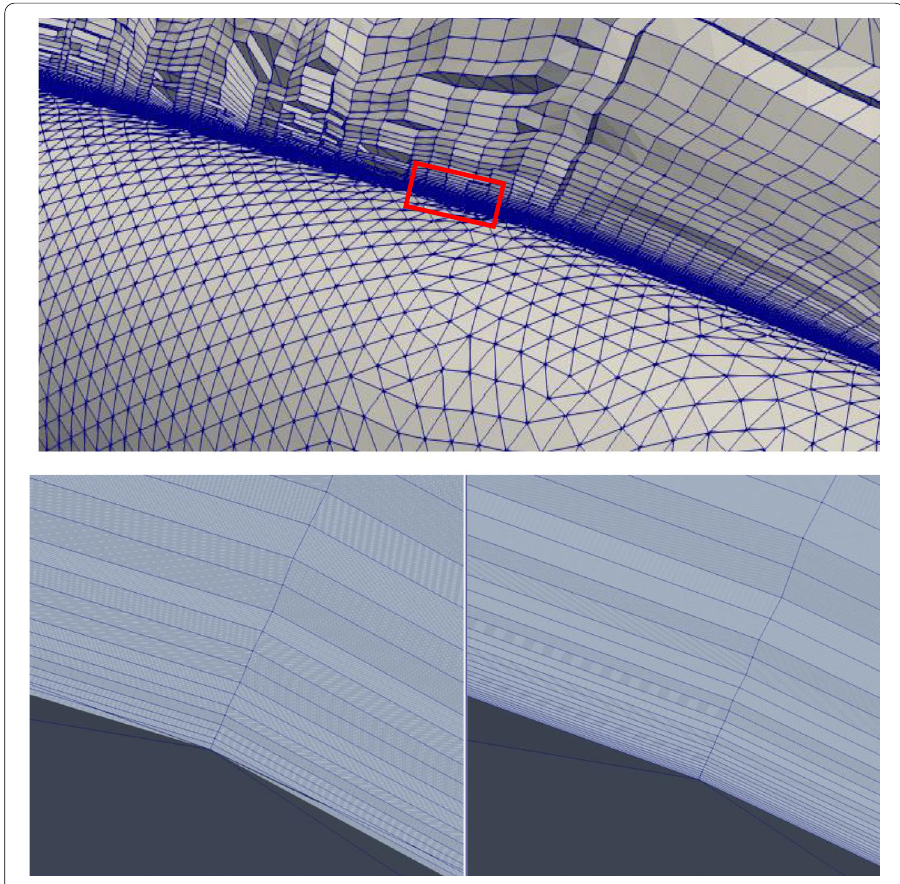
Fig. 12 Comparison of elements before and after mesh deformation. a The prism elements near the surface. b inverted elements. c corrected elements after RBF deformation